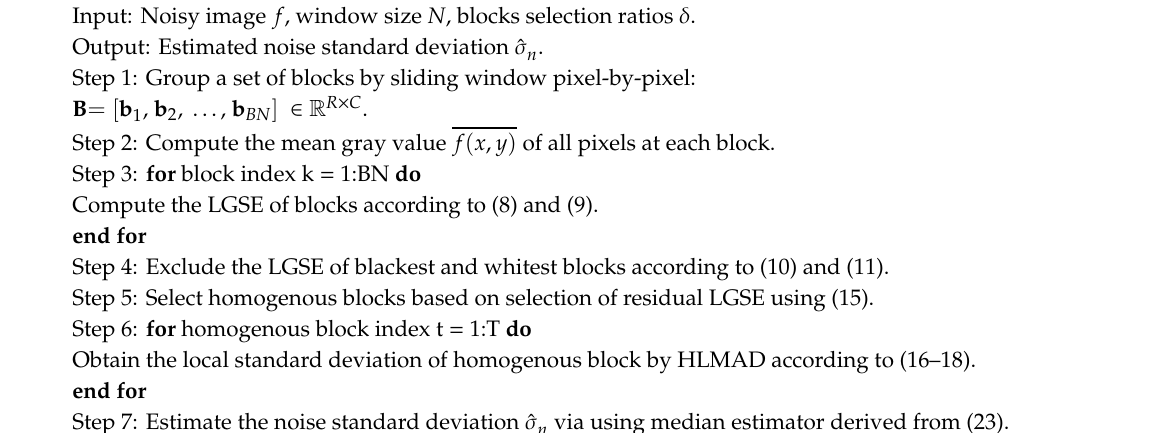
Algorithm 1. Proposed noise parameter estimation algorithm for the AWGN